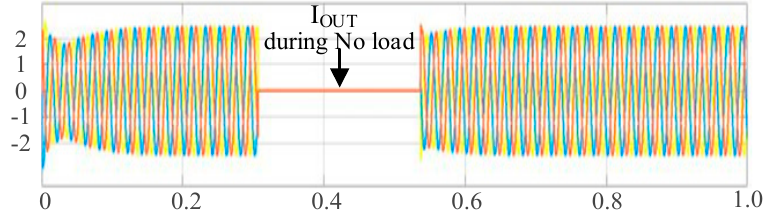
Figure 16. The output of the inverter during a sudden loss of the load. Furthermore, the HS-SZSC interfaced with the 3-phase H-bridge inverter is also tested at different loading as well as power factor conditions which are demonstrated in Figures 17 and 18, respectively. Figure 17 shows the variation in the efficiency with the load current (at unity power factor).